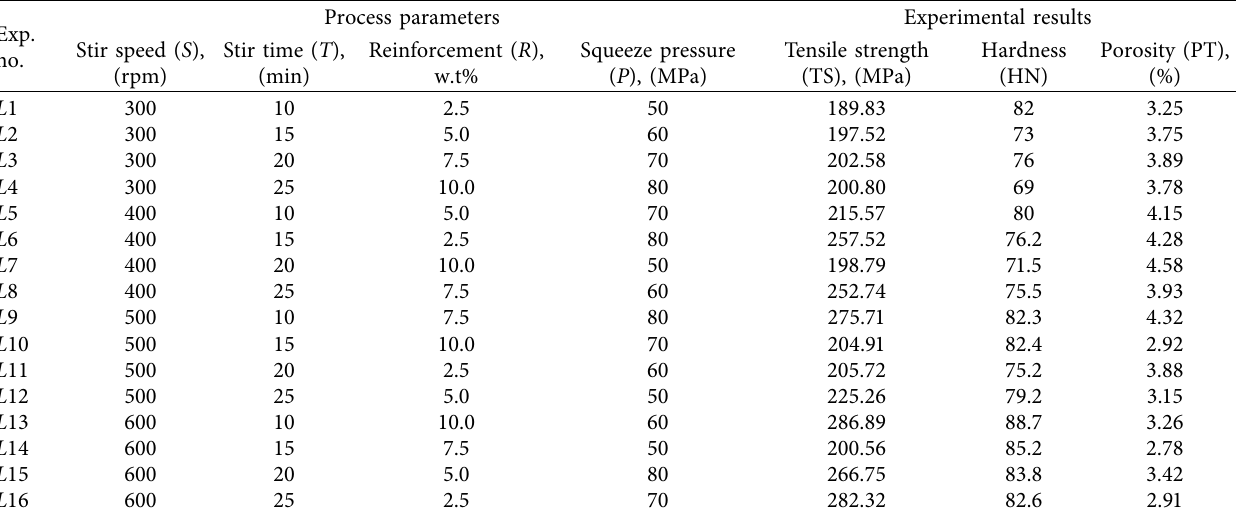
Table 4: Experimental results for the SSC process.